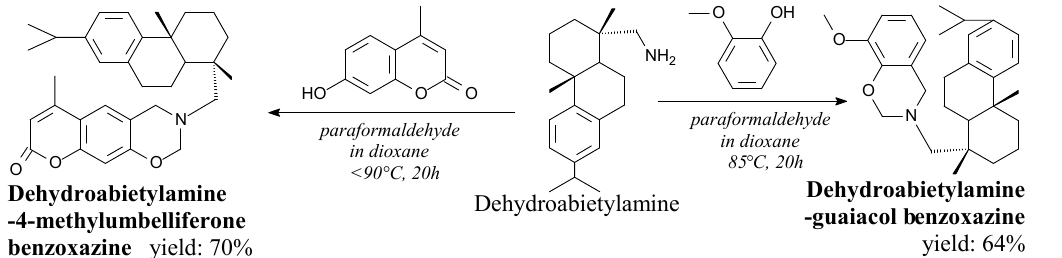
Scheme 20. Synthesis of maleopimaric acid imidophenol and its